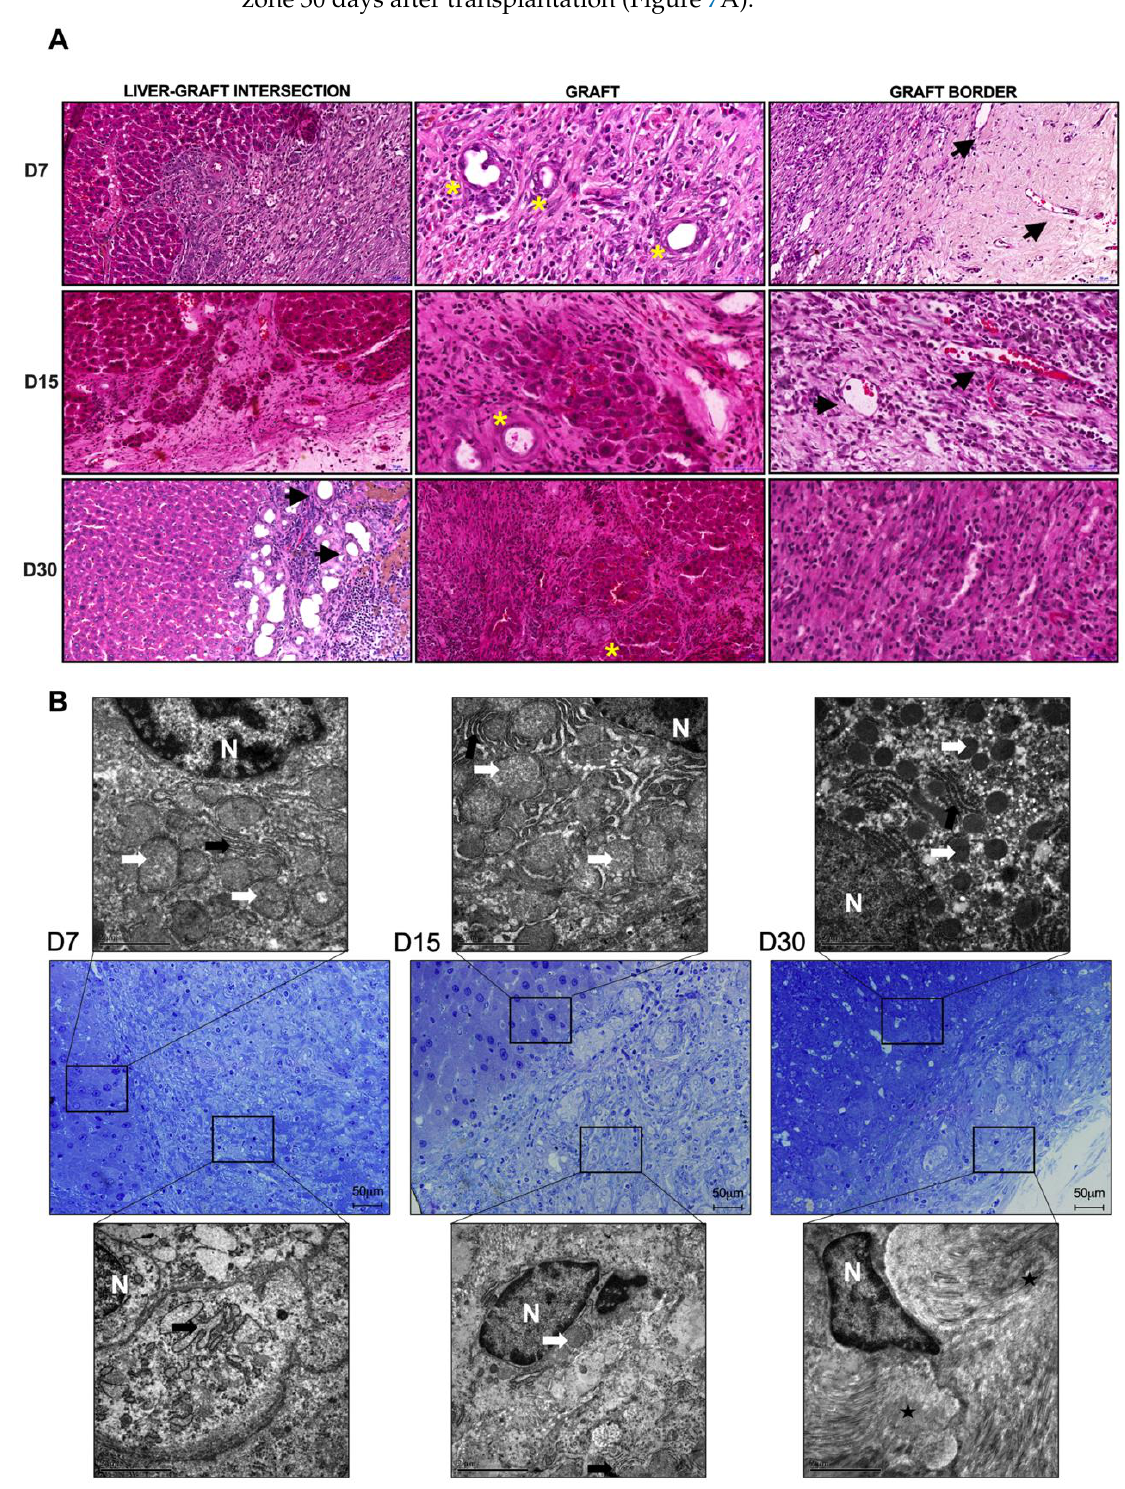
Figure 7. Cirrhoticratspromotein